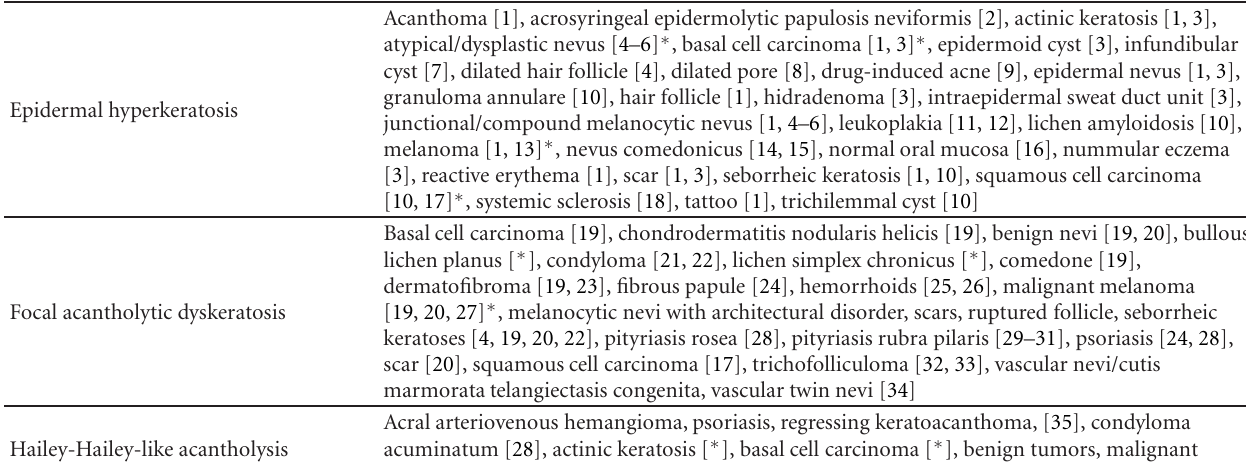
Table 2: Conditions reported in association with described incidental reaction patterns.